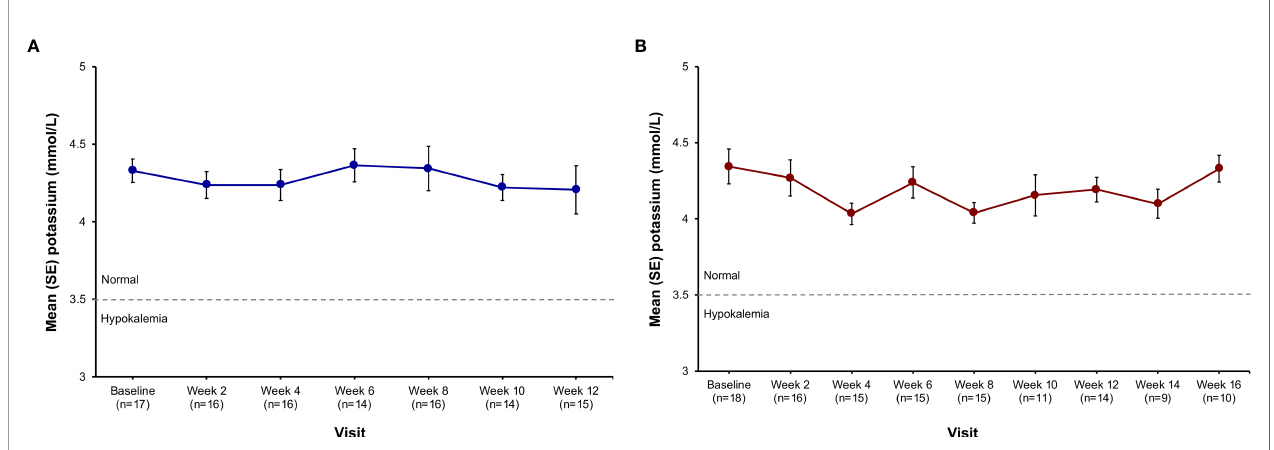
FIGURE 4 | Potassium levels by visit in the (A) low-dose group and (B)